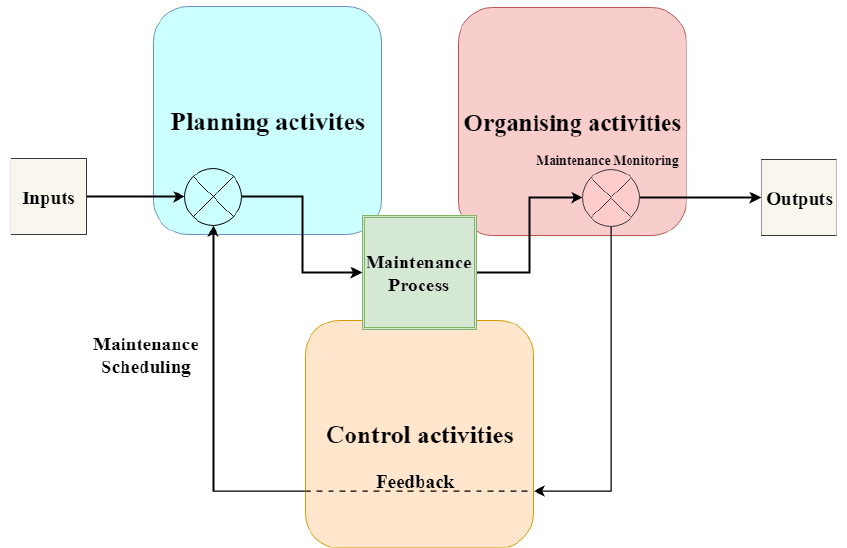
Figure 1. Maintenance Management System. Source: adopted from [14].